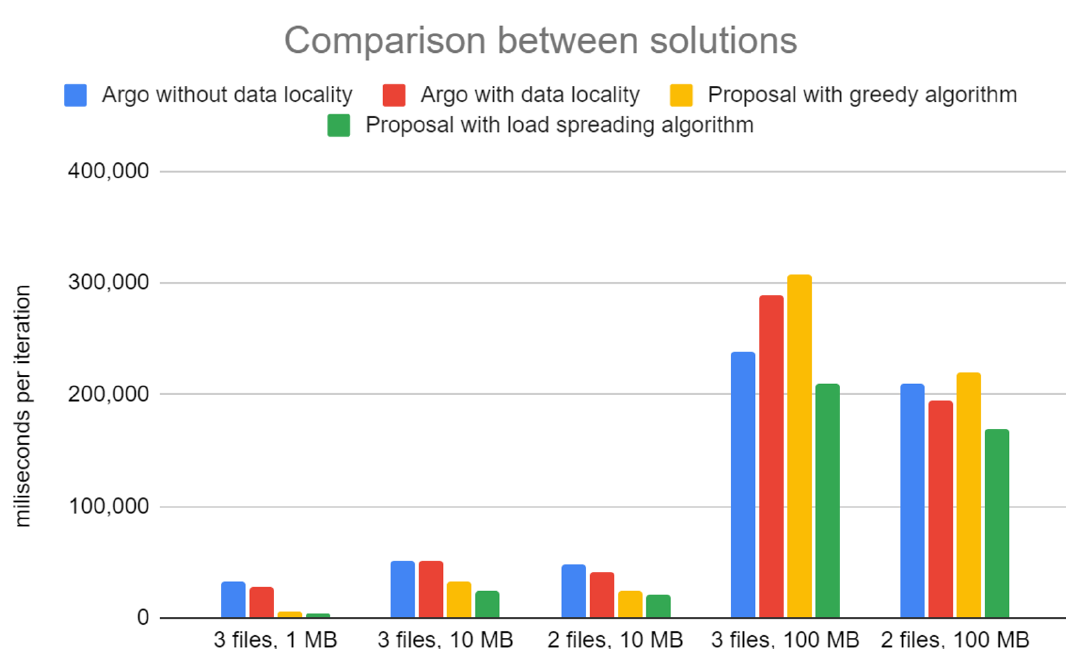
Figure 7. Performance comparison between the proposed solution and Argo